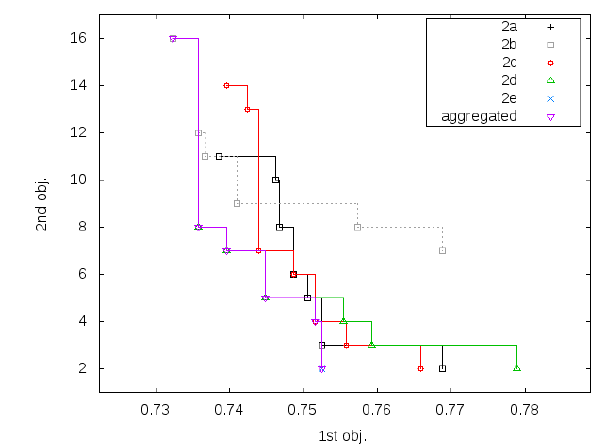
Fig. 7. The Pareto front approximations obtained for abalone using the five fitness functions. Objective 1 stands for test error and objective 2 for complexity. The pseudo- optimal Pareto front is also drawn for reference.